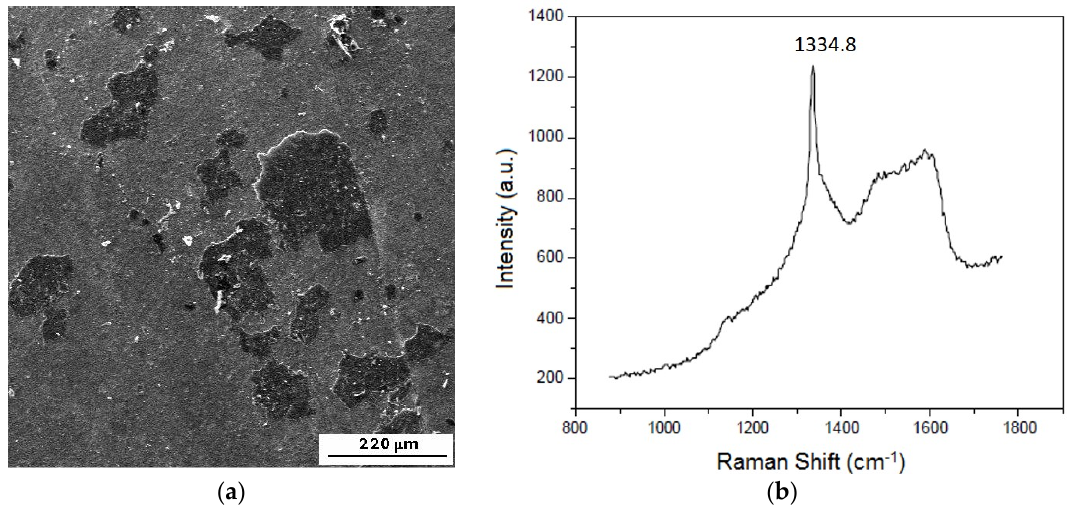
Figure 8. Hot filament chemical vapour deposition (HFCVD) diamond cover Fe2B/VC multilayer: ( a ) SEM image and ( b ) Raman spectrum (excitation with laser at 514.5 nm).